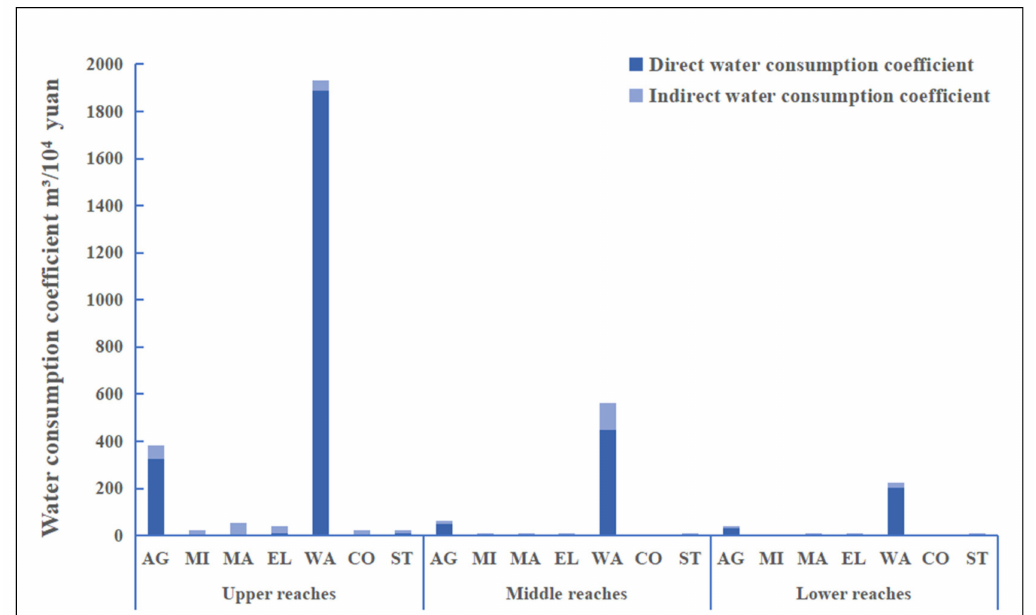
Figure 3. Water consumption coefficient in upper, middle, and lower